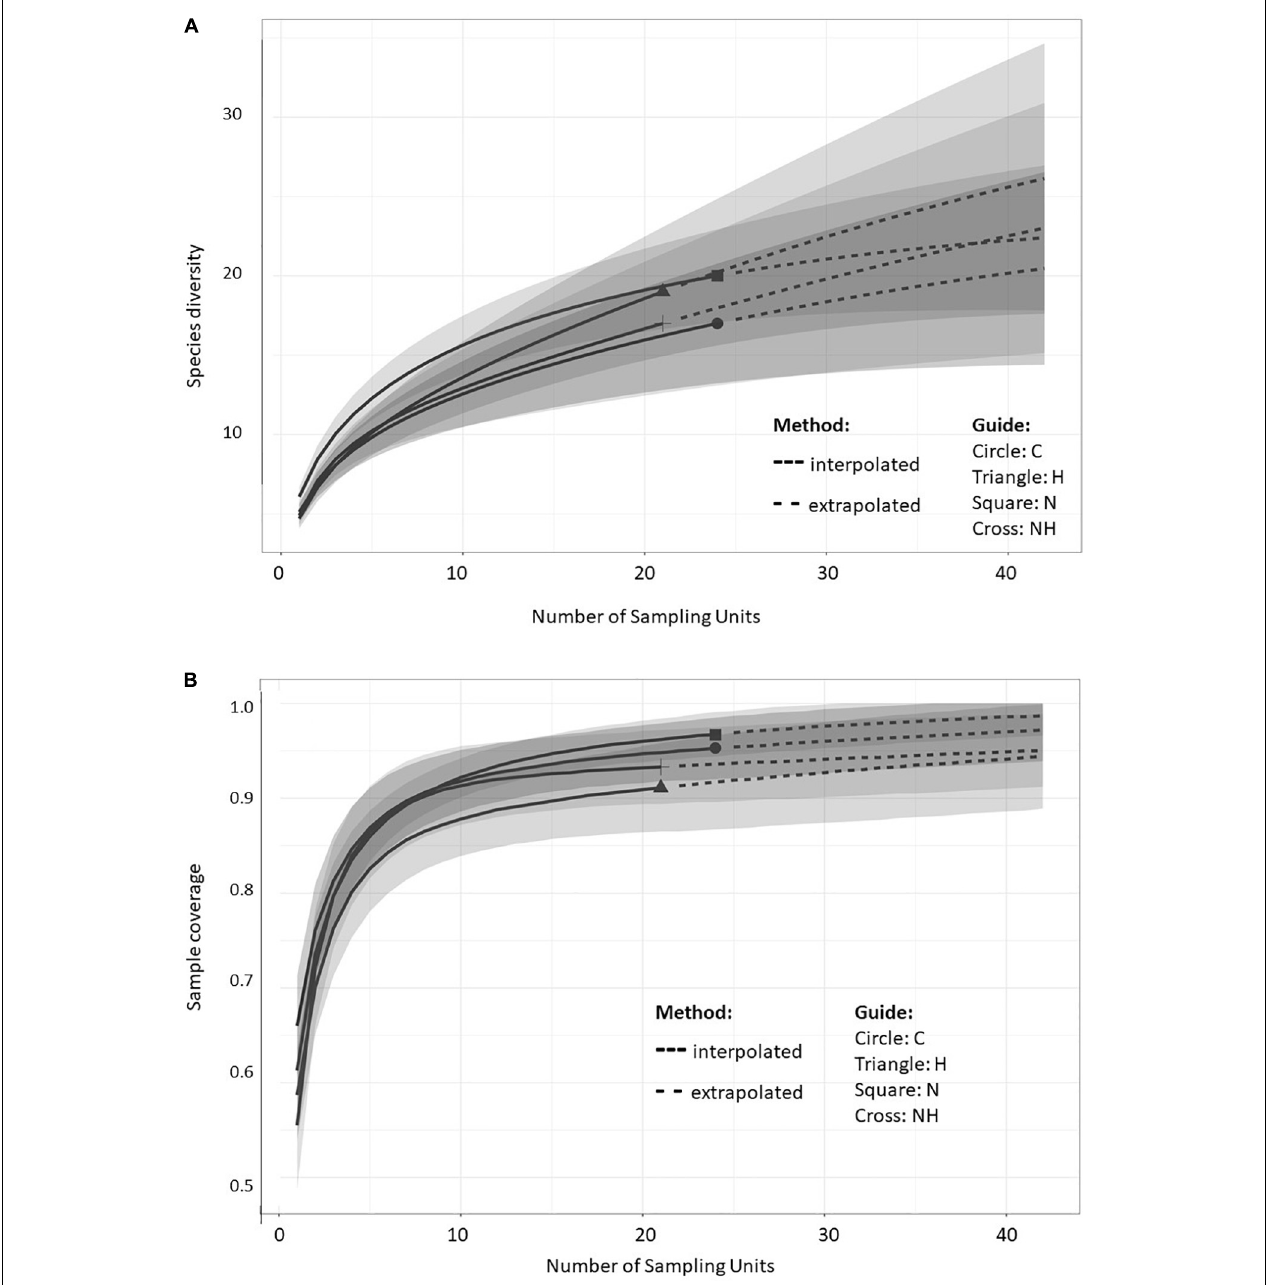
FIGURE 3 | Sample-size-based (A) and coverage-based (B) rarefaction (solid line) and extrapolation (dotted line) curves comparing fungal morphotype richness in the leaves of greenhouse-cultivated aspen ( Populus tremula ) plants ( n = 96): untreated control plants (C) and plants subjected to nitrogen addition (N), herbivory (H), or nitrogen addition and herbivory in combination (NH) ( n = 24 plants per treatment). The shaded areas represent the 95% confidence intervals. The different symbols represent the reference